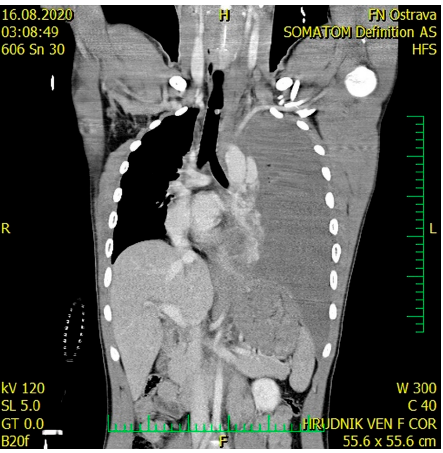
Figure 2. CT scan—large left-sided tension hemothorax with the mediastinal shift.